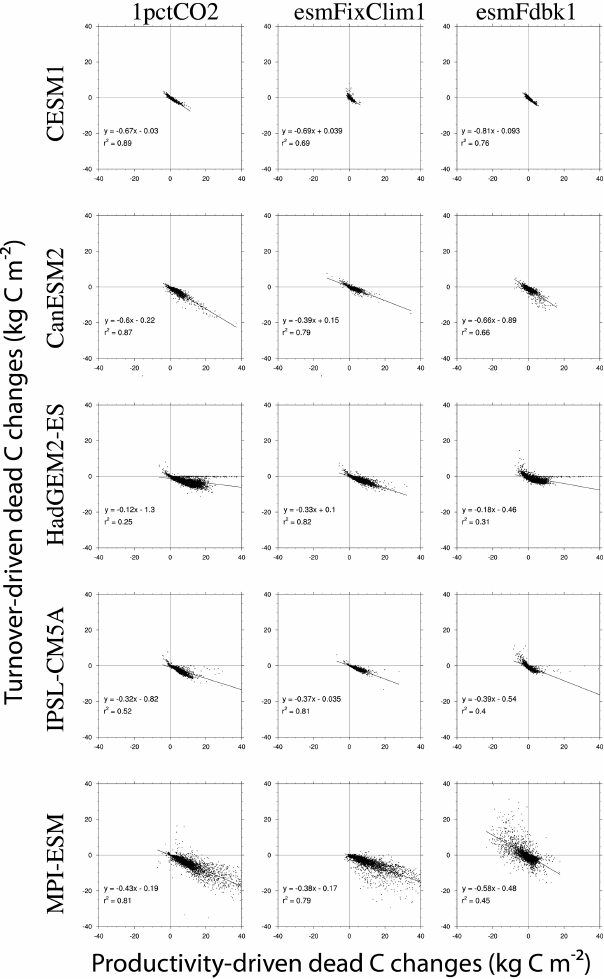
Figure 9. Scatterplots of productivity-driven vs. turnover-driven changes to the dead pool equilibrium carbon amounts for each model and